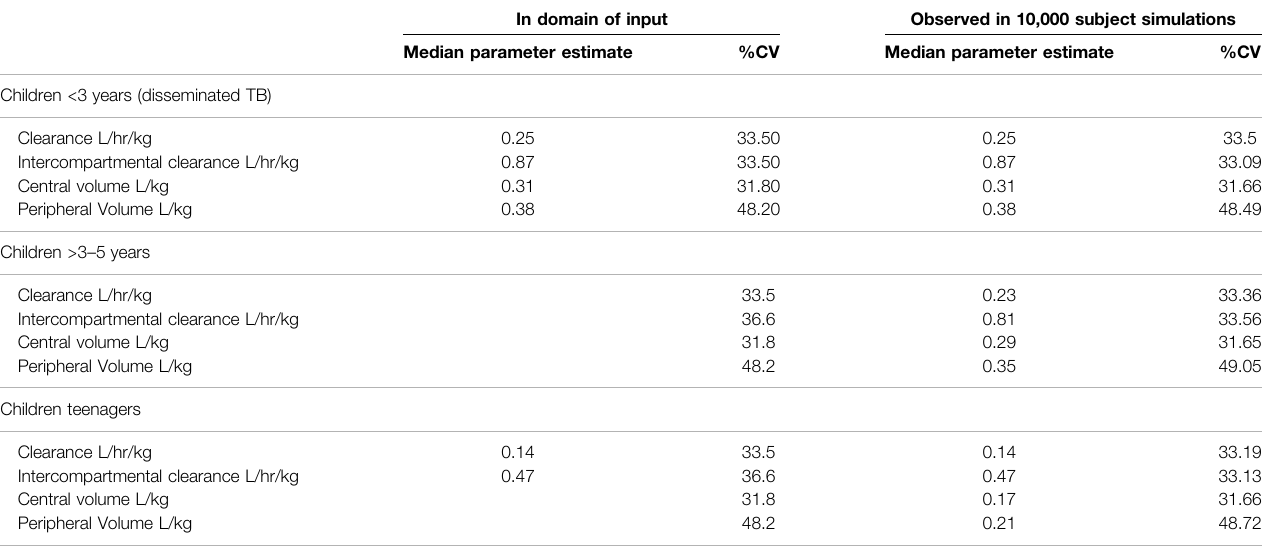
TABLE 1 | Monte Carlo simulation model input and output for 10,000 children.